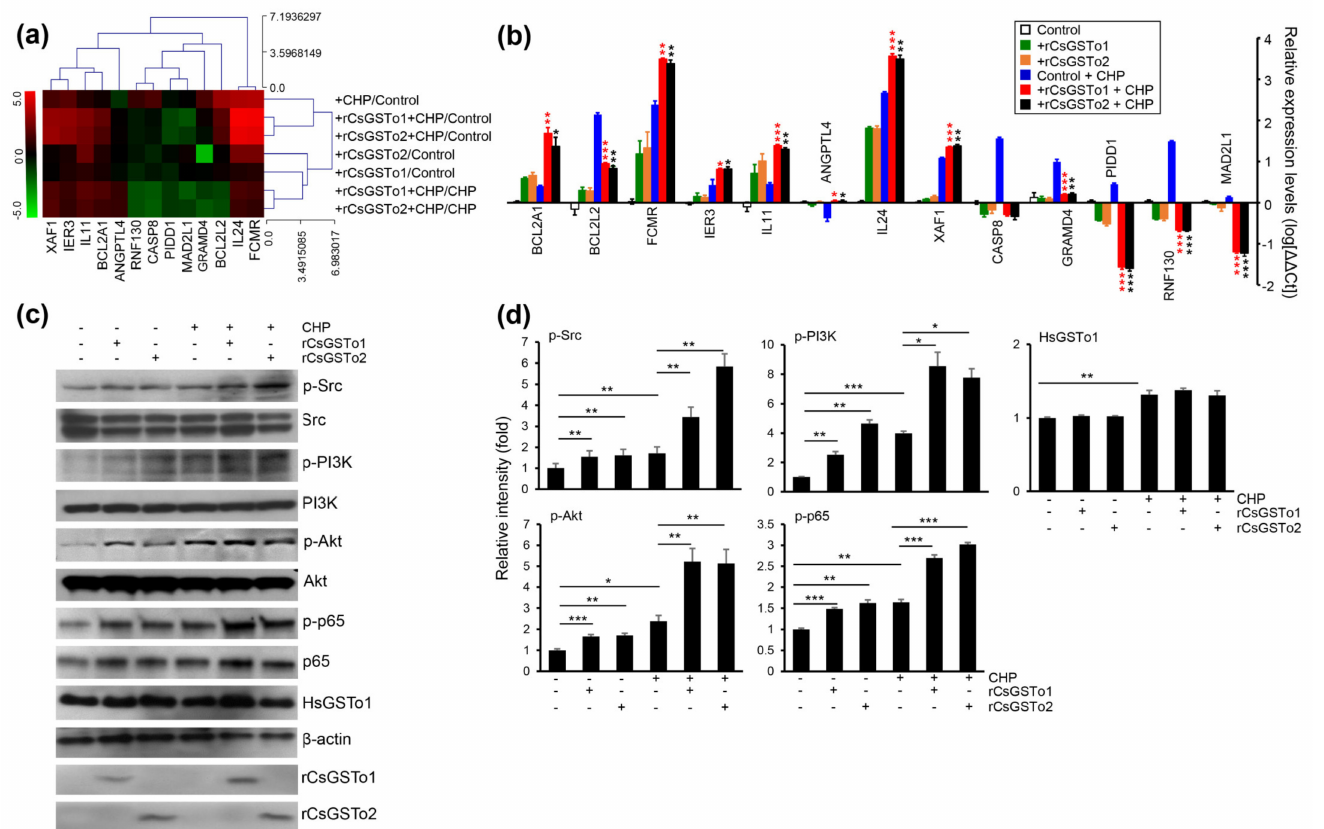
Figure 4. rCsGSTos increased active, phosphorylated forms of protein kinases involved in cell survival followed by controlling the transcriptional levels of apoptotic genes in response to oxidative injury. ( a ) A clustergram of genes involved in programmed cell death. Red and green in the hit map indicated maximal and minimal gene expression. ( b ) Transcription levels of genes shown in panel a were determined by qRT-PCR with gene-specific primers (Table S1). β -actin gene was used as an internal control for normalization. * p < 0.05, ** p < 0.01, *** p < 0.001. ( c ) Western blot analysis of phosphorylated forms of Src, PI3K, Akt, and NF- κ B p65. Detection of β -actin and rCsGSTos is also shown. ( d ) Relative fold intensity of kinases activated by phosphorylation. The intensity of Western blot bands was quantified by ImageJ analysis (https://imagej.nih.gov/ij/, accessed on 31 March 2020). * p < 0.05, ** p < 0.01, *** p <